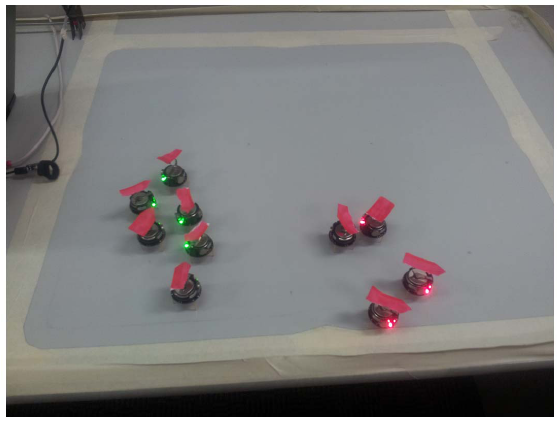
Figure 7. Setup for the kilobot experiments. The arrow marks the current heading of each bot.